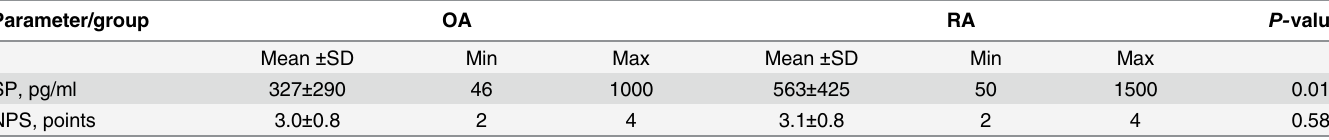
Table 1. Serum concentration of substance P and severity of chronic pain in both groups of patients.